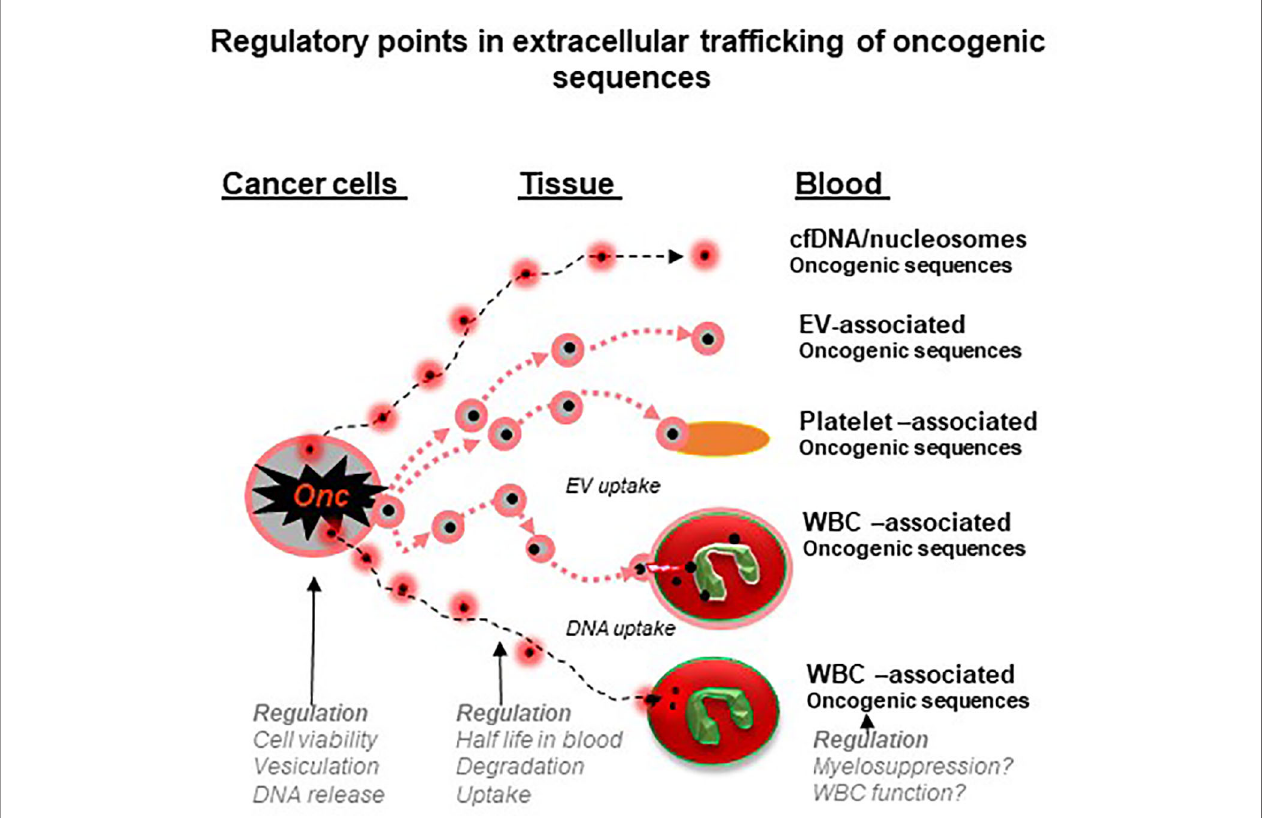
FIGURE 2 | Regulatory points in extracellular traf fi cking of oncogenic sequences in cancer (a hypothesis). Genomic DNA and mutant nucleic acids exit cancer cells either through secretory mechanisms, vesiculation or cell death. This material circulates in blood and bio fl uids as either particles (e.g. nucleosomes) or extracellular vesicles (EVs) and both may be ingested by platelets or white blood cells (WBCs). These cells may therefore act as reservoirs and regulatory mechanisms to control the levels of cancer-related nucleic acids. In addition, processes that in fl uence the state and function of blood cells may in fl uence their storage capacity for cancer- related material and possibly the circulating levels of liquid biopsy analytes (see text for